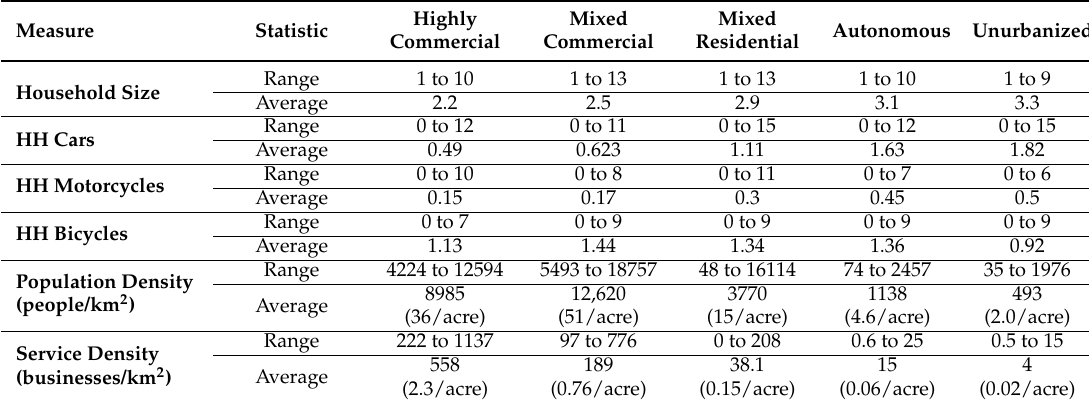
Table 2. Household and area characteristics of the five built environment